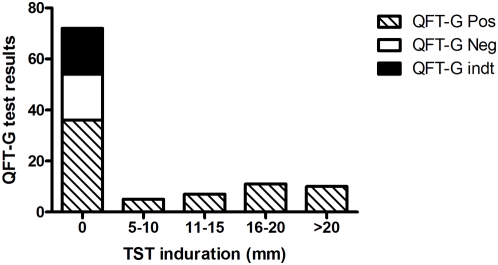
Agreement between TST and QFT-G test results.Among the 105 subjects tested, 72 were negative for TST. Of the 72 TST negative, 50% were positive for QFT-G. None of the TST positive was negative or indeterminate for QFT-G. TST-Tuberculin Skin Test, QFT-G-Quantiferon TB Gold in-tube, Pos - Positive, Neg - Negative, Indt – Indeterminate.